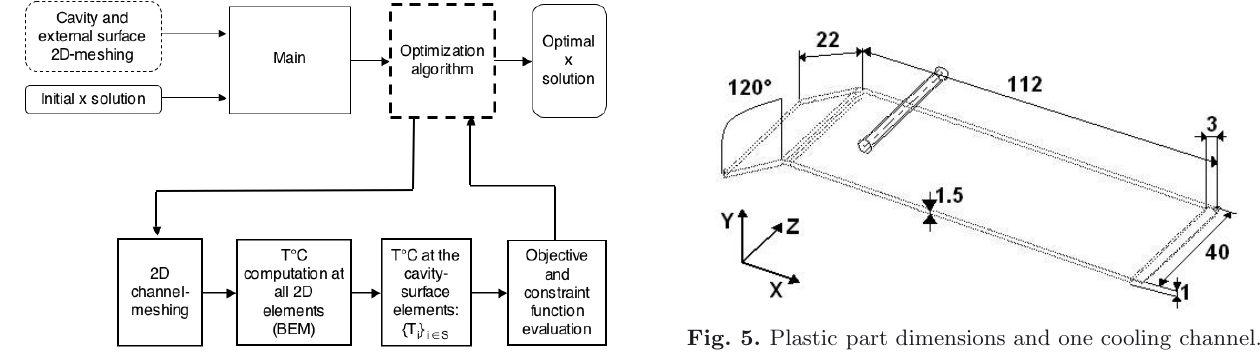
Fig. 4. The heat-transfer simulation coupled with the opti- mization algorithm.